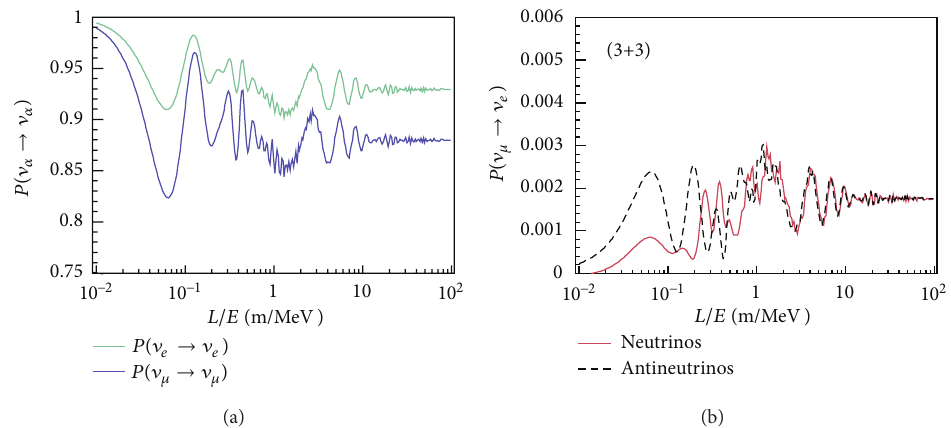
Figure 16: The ( 3 + 3 ) oscillation probabilities for the global best-fit (“all” datasets) values in Table 3 with 10% resolution in 𝐿/𝐸 .